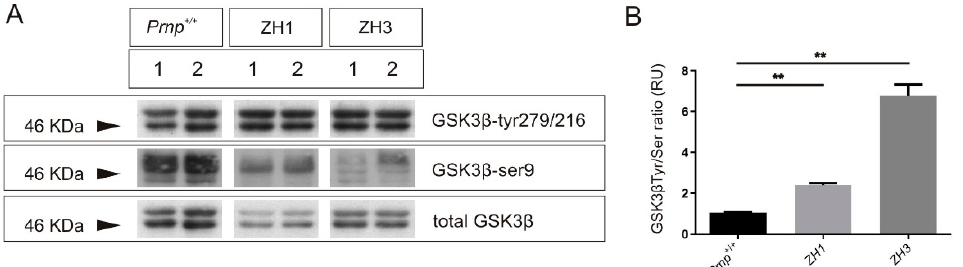
Figure 2. GSK3 β activity in mice devoid of PrP C expression. ( A , B ) GSK3 β activation analyzed by WB in brain extract from WT and Prnp 0/0 mice ZH1 or ZH3 at the age of 3 months. ( A ) Representative WB analysis using anti-phospho-tyr 279/216 GSK3 antibody (monoclonal 5G-2F) in parallel with anti-phospho-ser 9 GSK3 antibody (monoclonal 2D3) in each case. Membranes were re-probed with antibody against total GSK3 (monoclonal 4G-1E) for protein standardization. ( B ) Histograms showing the quantified ratio between phospho-tyr 279/216 and phospho-ser 9 after densitometry analysis of both phosphorylated GSK3 β epitopes in each genotype, which represents the kinase activity. n = 3 mice were examined in each group and data represent the mean ± S.E.M. Differences between groups were considered statistically significant at ** p < 0.01 ( t -test).